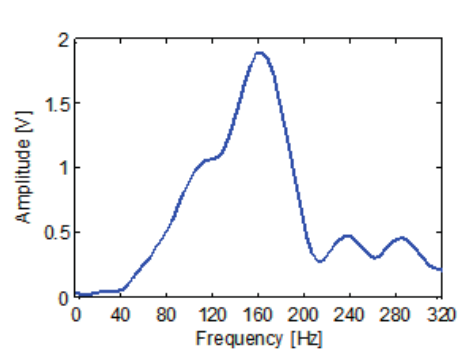
Figure 9. Sensor burial mode.